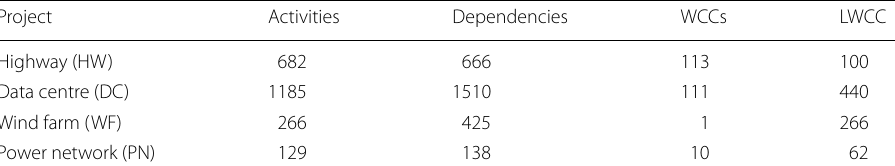
Table 1 For each of the four activity networks we report the number of activities (nodes), dependencies (directed links) and weakly connected components, and the size of the largest weakly connected component